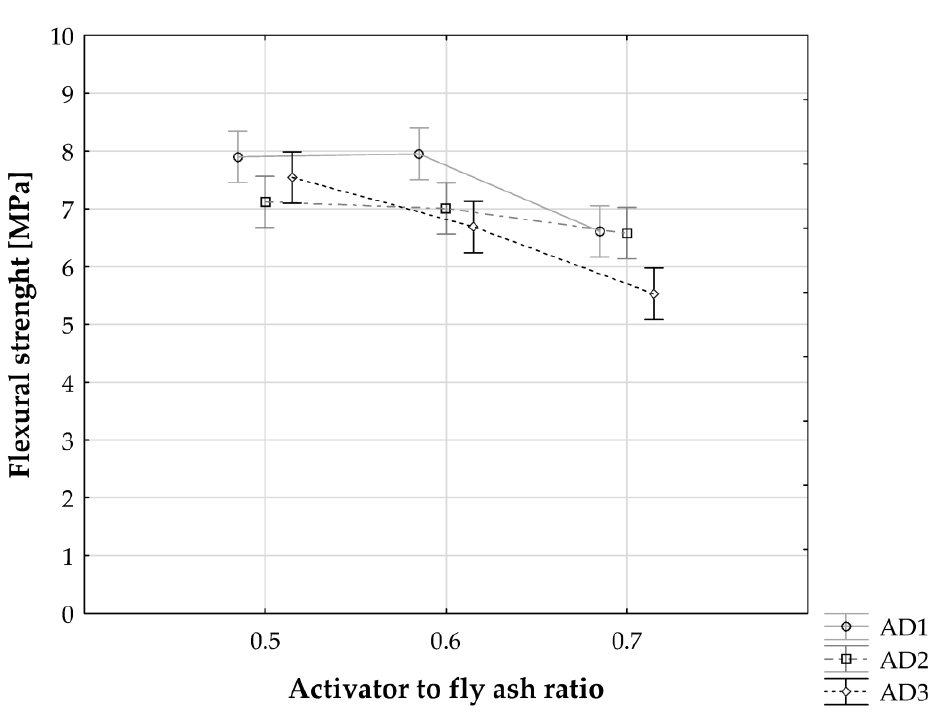
Figure 2. Flexural strength results depending on the activator to fly ash ratio (ANOVA certainty in whiskers). in